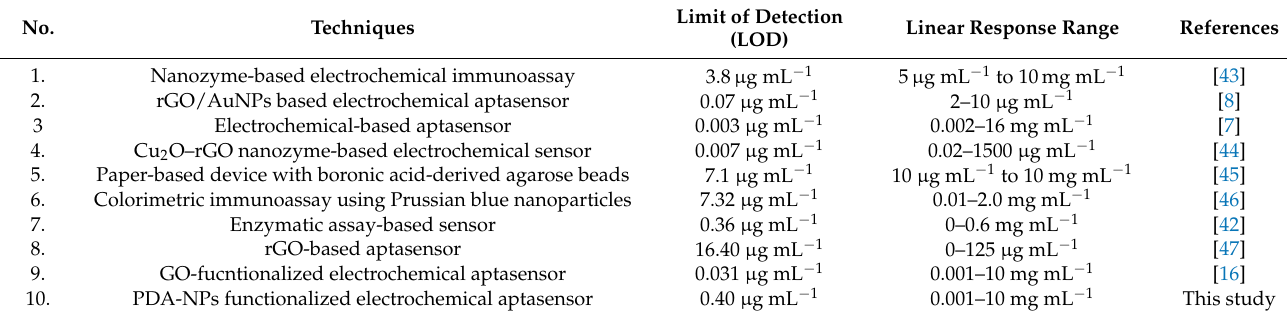
Figure 8. ( A ) CV response of Aptamer/PDA/SPCEs aptasensor after incubation with concentrations of 1 µ g mL − 1 , 10 µ g mL − 1 , 100 µ g mL − 1 , 1 mg mL − 1 , and 10 mg mL − 1 . ( B ) The calibration curve for GA detection showing linear relationship between the logarithm of GA concentration 1–10,000 µ g mL − 1 and corresponding maximum current ( ∆ I) from CV. Mean current value of each concentration was plotted from three independent experiments. Table 1. Comparison of limit of detection using various biosensors for the detection of serum glycated